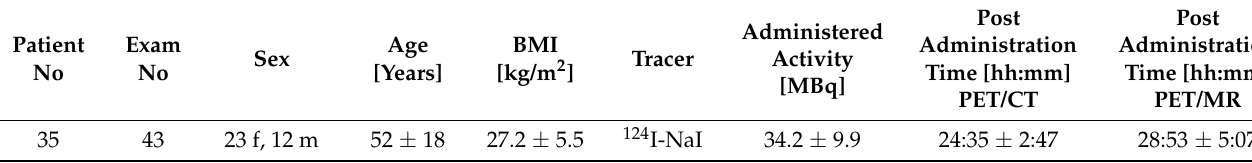
Table 1. Detailed patient and examination information. Values are given in mean ± standard